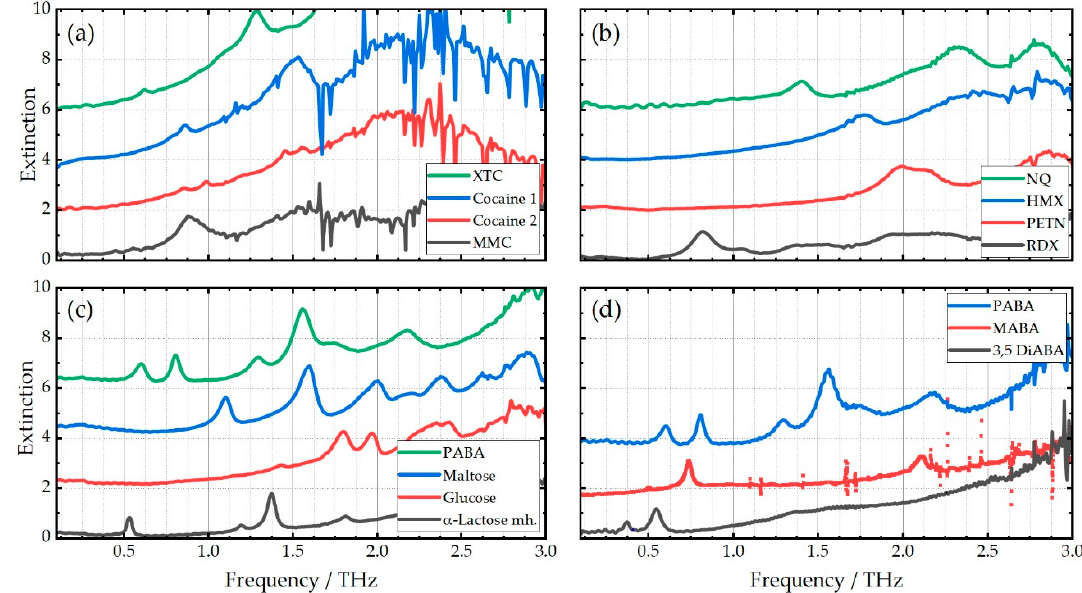
Figure 3. Spectra of ( a ) drugs, ( b ) explosives, ( c ) mock-up substances (simulants), and ( d ) isomers of aminobenzoic acids acquired with the terahertz TDS system used in the mail inspection system. While each substance shows characteristic absorption features, the number of features and their amplitude differ significantly. The shown cocaine spectra are typical for the two classes of cocaine that can be found on the market. Spectra are vertically shifted for better readability.